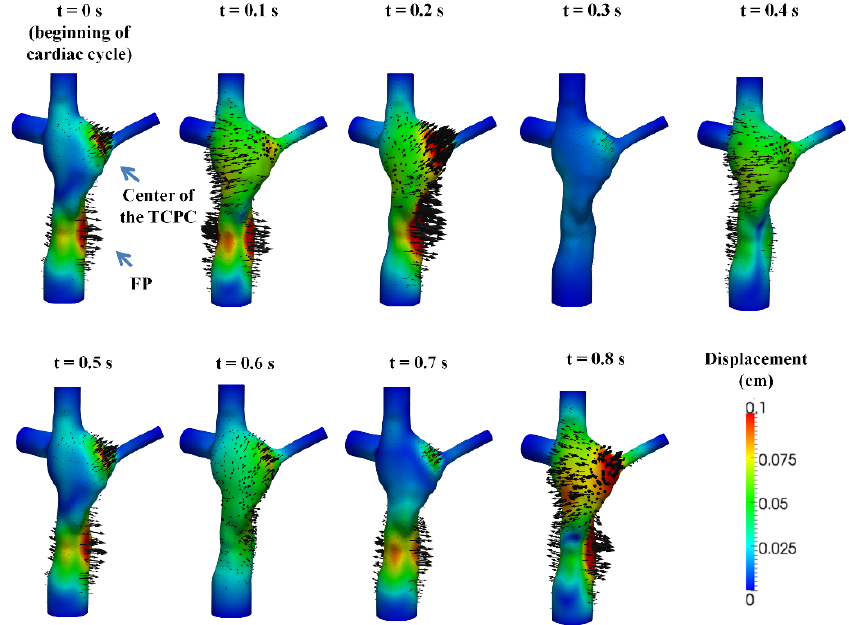
Figure 5. The simulated displacement fields at nine evenly spaced time points in the cardiac cycle. The color of the contour represents the magnitudes of the displacement and the arrows represent the direction of the displacement.